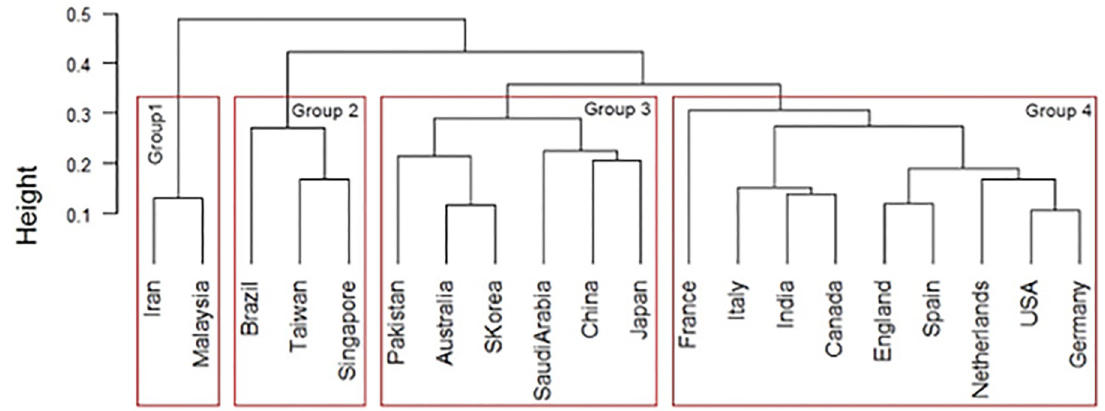
Fig 8. Similarity dendrograms by country: Links between author research fields in the top 20 countries for artificial intelligence. Note . Distance: hclust ( � , “ward.D2”).